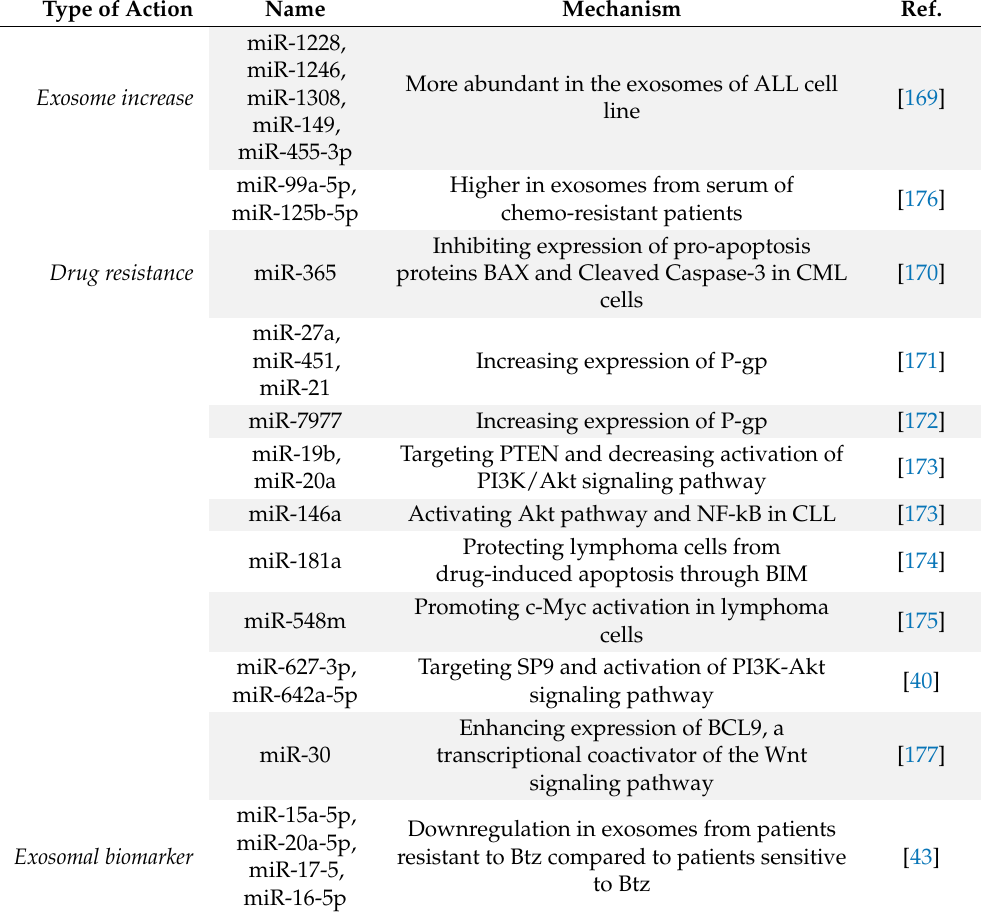
Table 2. Principal type of action of exosomes and related miRNAs with their specific